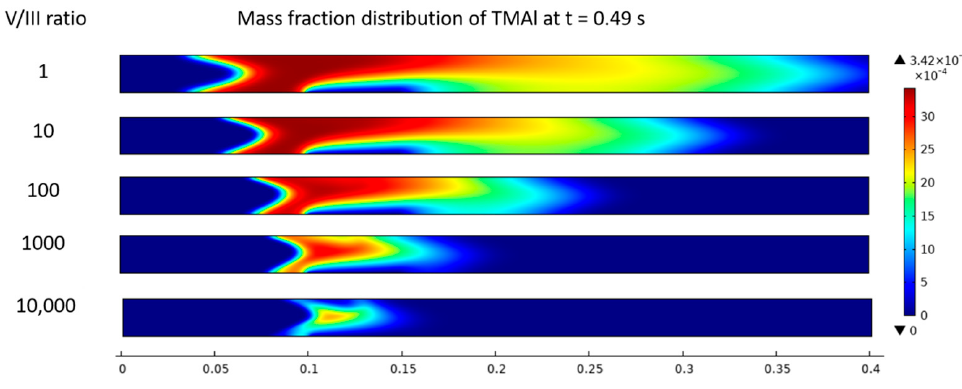
Figure 7. Mass fraction distributions of TMAl at 0.49 s for different V/III ratios.